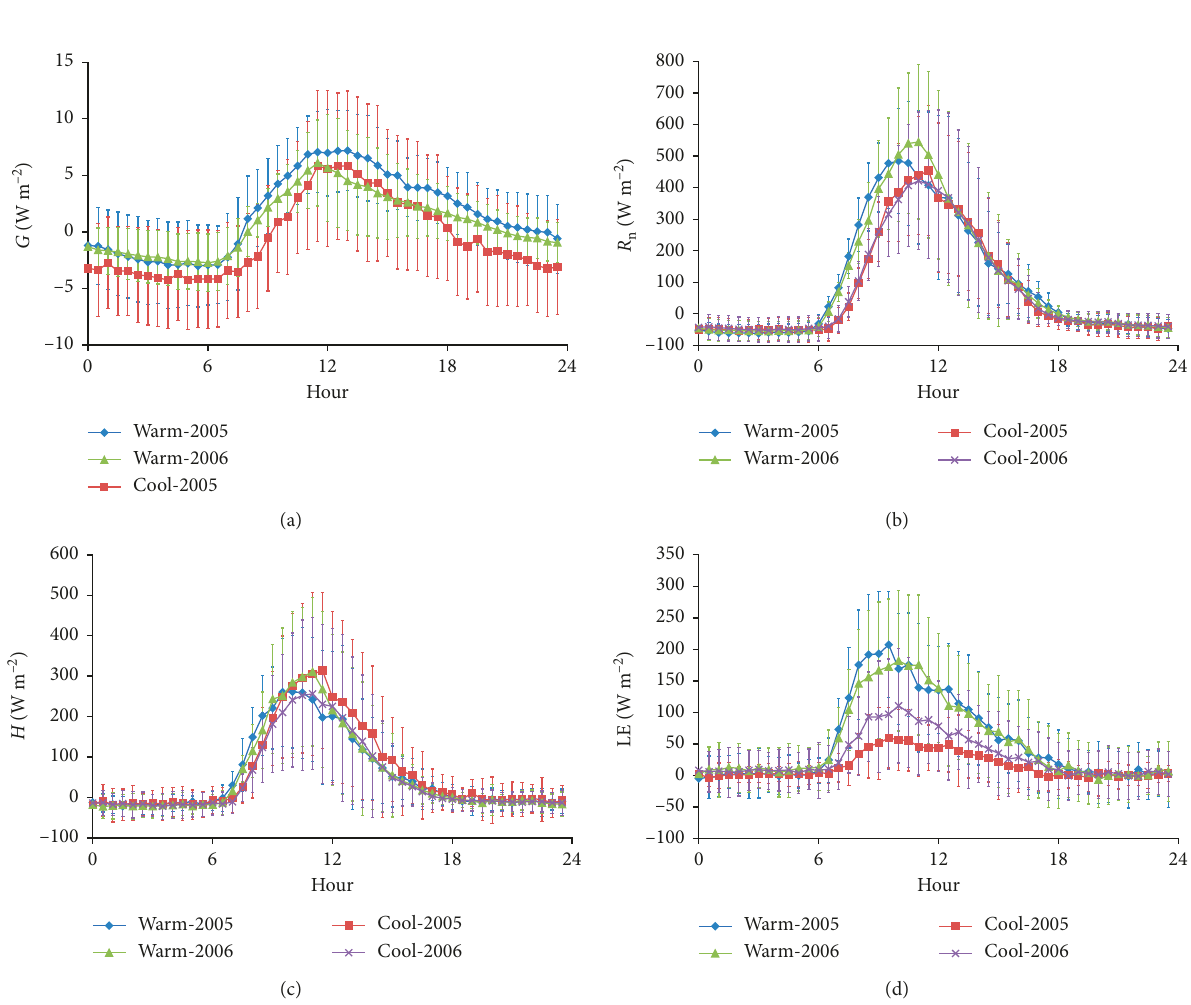
Figure 2: Averaged diurnal variations of (a) G , (b) R n , (c) H , and (d) LE for the warm (May to Oct.) and cool (Nov. to April) seasons of 2005–2006. The vertical bars indicate the standard